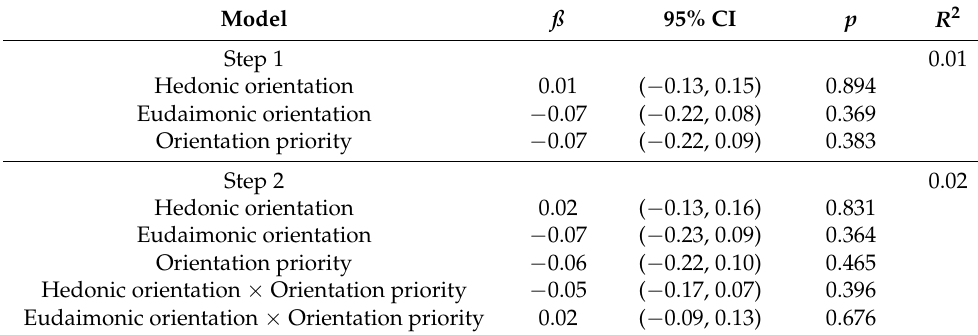
Table 4. Regression results using negative affect as a dependent variable.